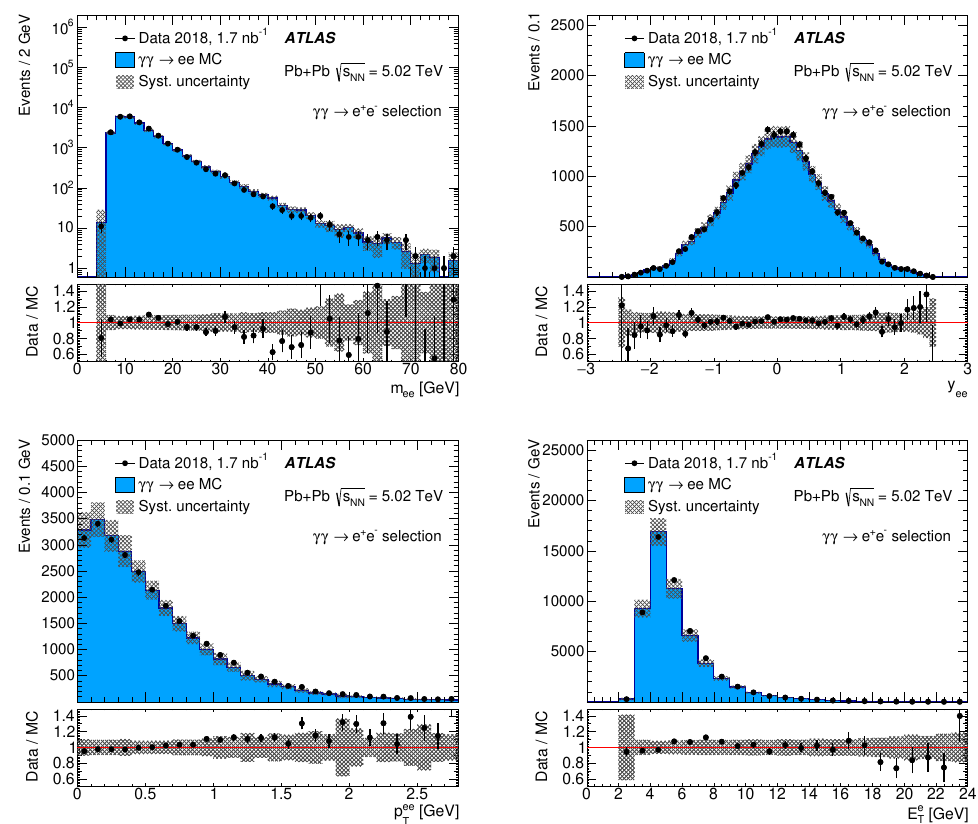
Figure 5 . Kinematic distributions for Pb+Pb ( γγ ) → Pb ( ∗ ) +Pb ( ∗ ) e + e − event candidates in the 2018 data set: dielectron mass (top-left), dielectron rapidity (top-right), dielectron p T (bottom-left) and electron transverse energy (bottom-right). Data (points) are compared with MC expectations (histograms). The simulation prediction is normalised to the same integrated luminosity as the data. Systematic uncertainties due to electron energy scale and resolution, electron reconstruction and identification, and trigger efficiency, are shown as shaded bands. The lower panels display the ratio of data to MC predictions. Some values are outside the plotting